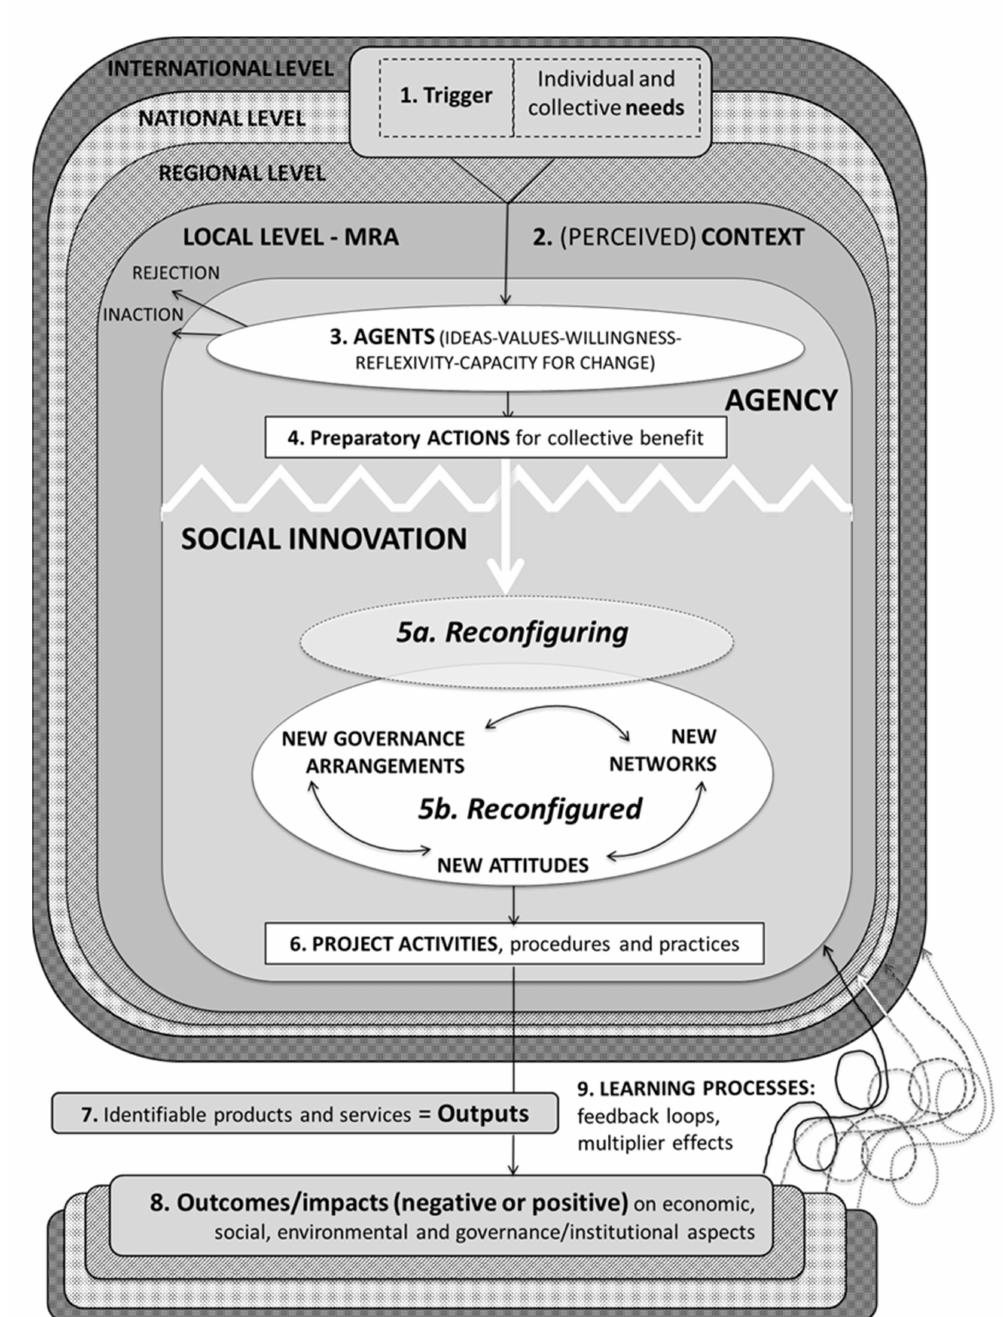
Figure 1. Social Innovation: a conceptual model. Source: